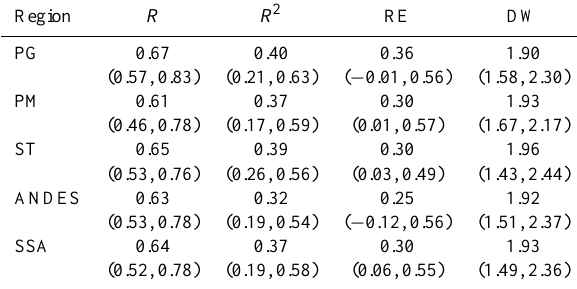
Table 2. Mean calibration and validation statistics for each region of SSA. Median values were averaged and the minimum and maxi- mum are given in